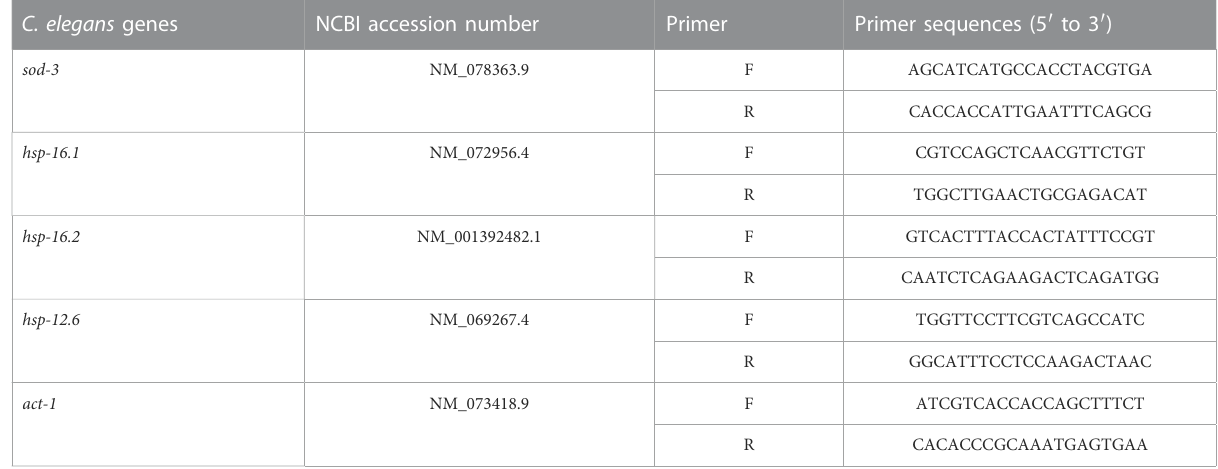
TABLE 1 Primer sequences used for qRT-PCR